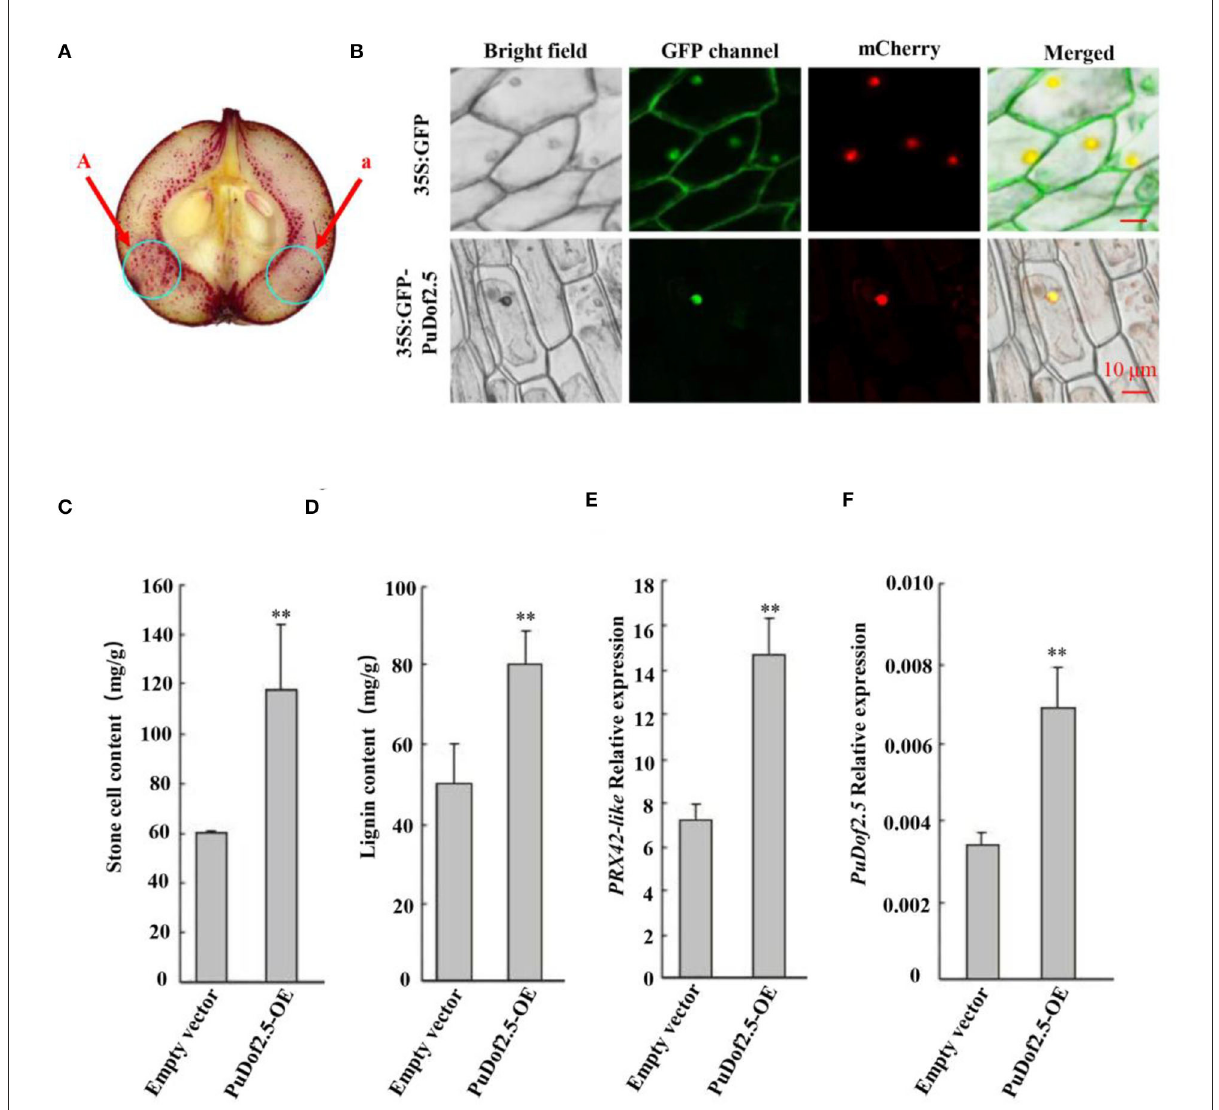
FIGURE5 Functional analysis of PuDof2.5 . (A) staining the sections with phloroglucinol-HCl (A, pRI101-PuDof2.5; a, pRI101). (B) Subcellular localization of PuDof2.5 was determined by transiently overexpressing PuDof2.5 , 35Spro ::GFP, and 35Spro :: PuDof2.5 -GFP constructs in onion bulb cells; PM marker served as a membrane marker (scale bar 10 µ m). (C) Stone cell content and (D) lignin content were measured. (E) PuPRX42-like and (F) PuDof2.5 expression levels in PuDof2.5-OE fruits were determined by qRT-PCR. Data are shown as mean ± SE (n = 3). Statistical significance was determined by Student’s t -test: ** P <